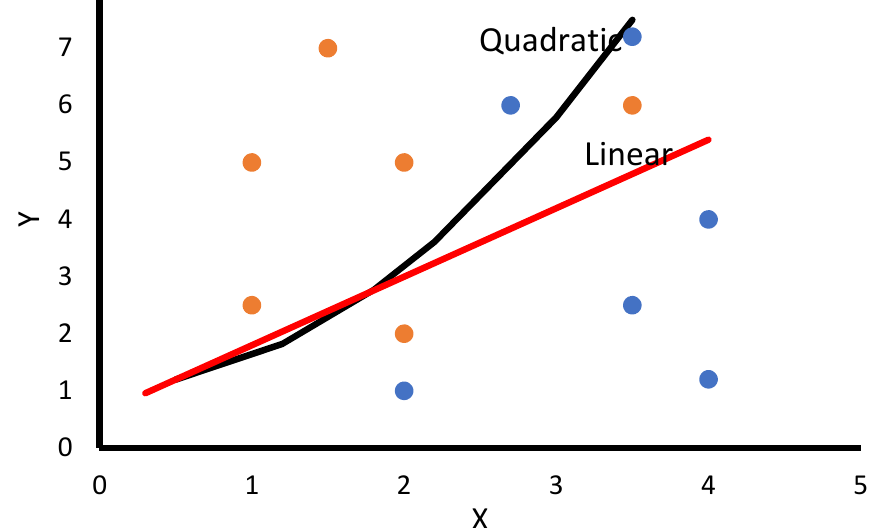
Figure 3. A variety of curves that separate between two classes in a discriminant analysis classifier.